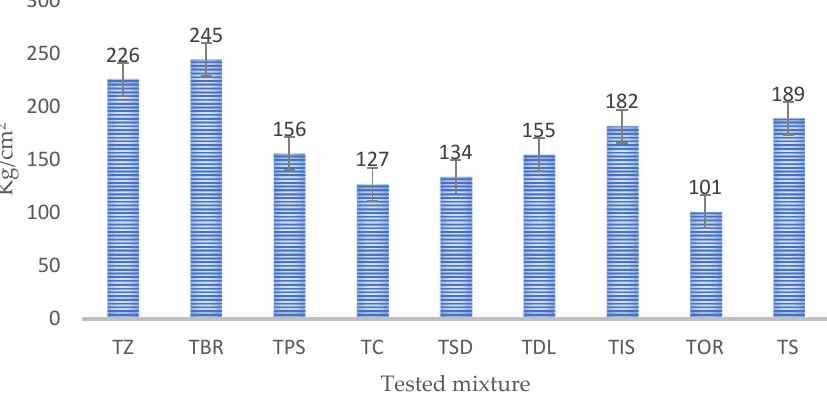
Figure 12. Bending strength values of every tested mixture (900 °C).